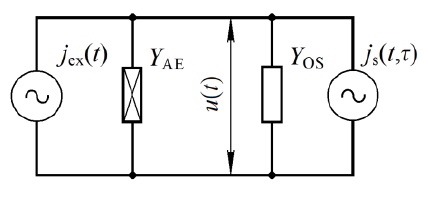
( t ) and j ( t , τ) on the diagram in Fig. 1 ex s